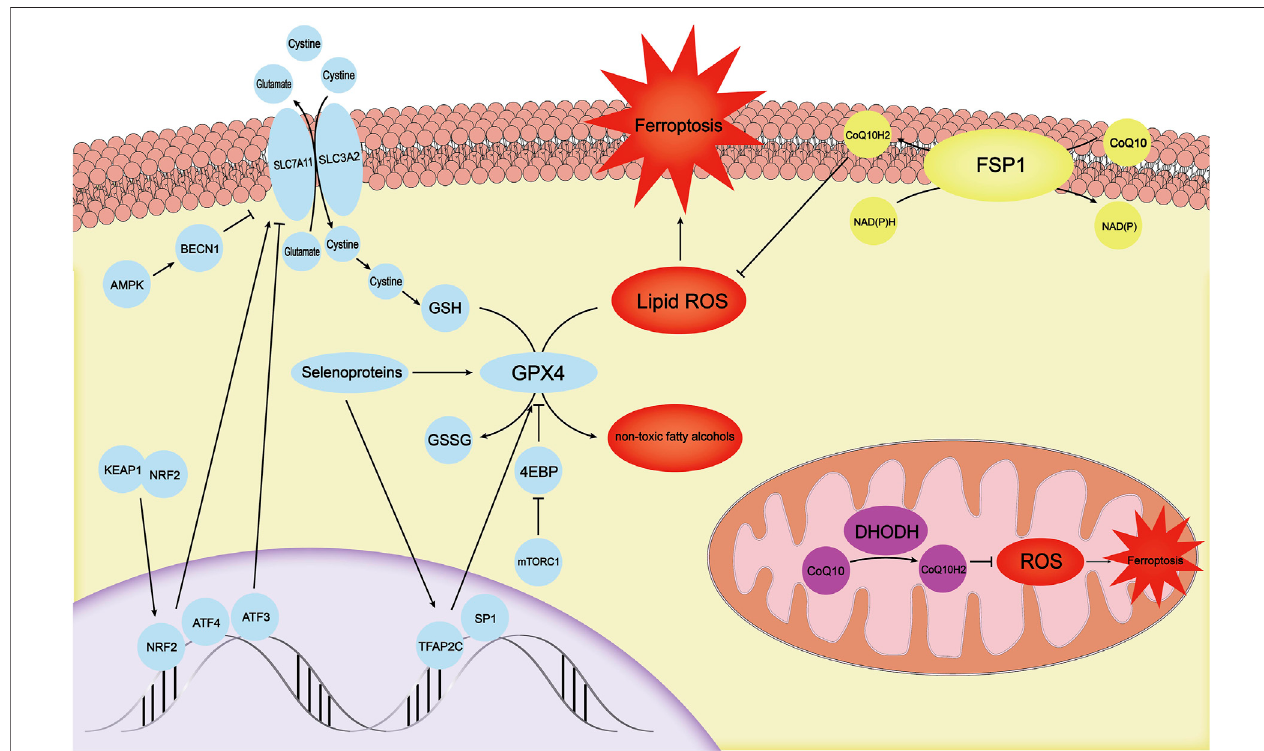
FIGURE 2 | There are three independent antioxidant systems in cells. The antioxidant system with GPX4 as the core is the fi rst antioxidant system discovered. It is regulated by mechanisms such as TFAP2C, SP1, mTOR-4EBP, and selenoproteins. SLC7A11, which provides a substrate for GPX4, is regulated by ATF3, ATF4, KEAP1-NRF2, and AMPK-BECN1. The FSP1-CoQ10-NADPH system, another antioxidant system in the cell membrane, can inhibit ferroptosis through CoQ10H2. DHODHprimarilyinhibitsROSinmitochondriabysynthesizingCoQ10H2toavoidtheferroptosisprocessinmitochondria.GPX4,glutathioneperoxidase4;mTOR, mechanistic target ofthe rapamycin complex 1; ATF3, activating transcription factor 3; ATF4, activating transcription factor 4; KEAP1, kelch-like ech-associated protein 1; NRF2, NF E2 Related Factor 2; AMPK, AMP-activated protein kinase; FSP1, Ferrop-Suppressor-Protein 1; NADPH, nicotinamide adenine dinucleotide phosphate; DHODH, dihydroorotate dehydrogenase; ROS, reactive oxygen species.